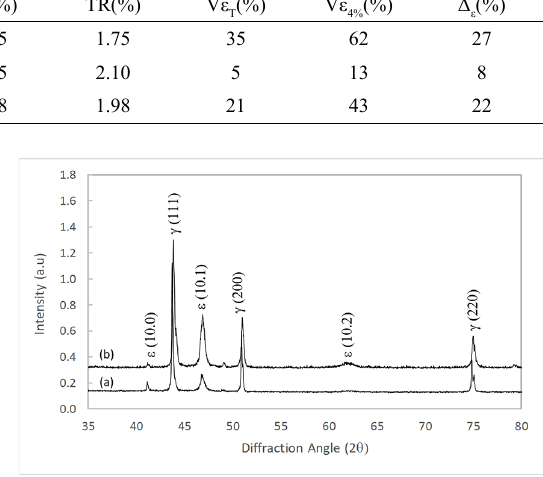
Figure 8. X-Ray Diffraction Patterns: (a) ST + 2ECAE + 950ºC, (b) ST + 2ECAE+ 950º + 4 % compressive